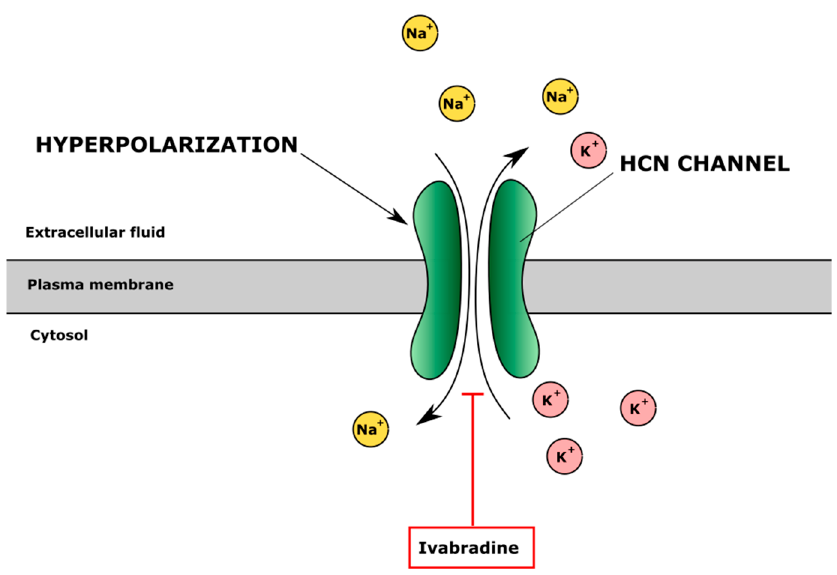
Figure 5. The effect of inhibitor of hyperpolarization-activated cyclic nucleotide-gated (HCN) chan- nels ivabradine on ion regulation. Ivabradine blocks HCN channel inhibiting Na + influx and K + efflux and changes intracellular and extracellular ion balance and cell membrane potential.